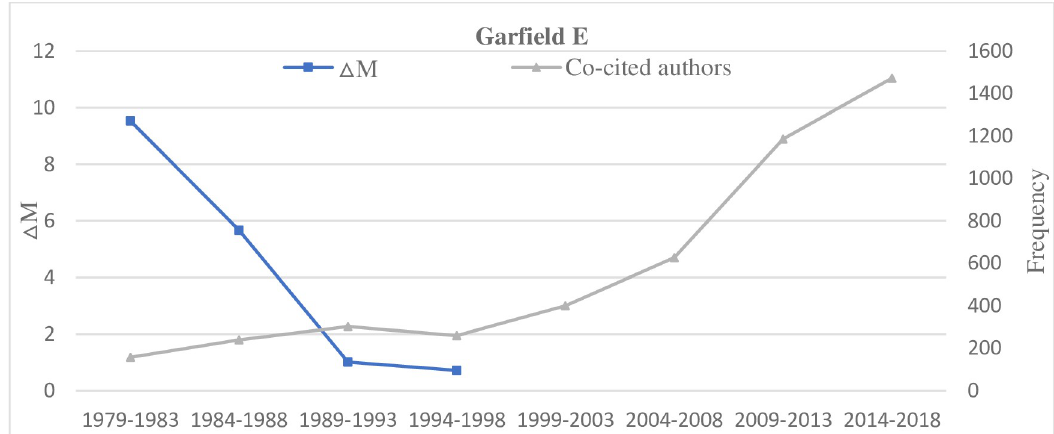
Fig 5. A decreasing Δ M and an increasing co-cited author frequency of Garfield